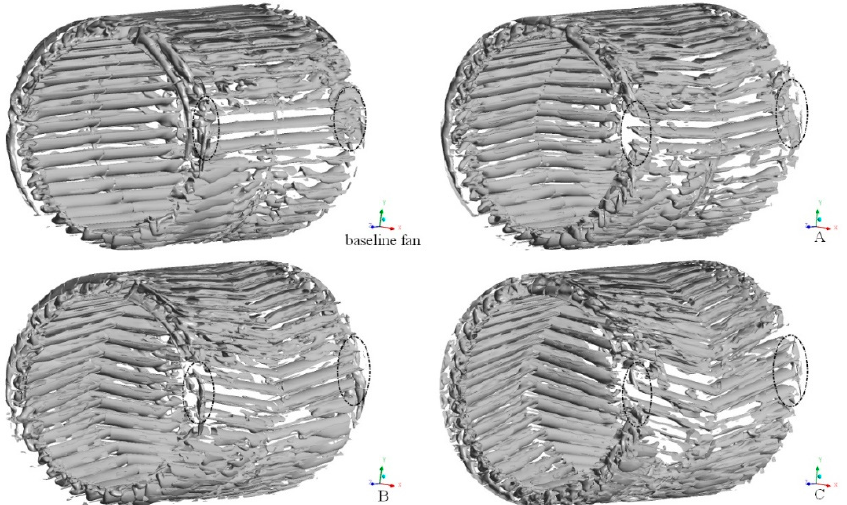
Figure 25. Three-dimensional distribution of vortices in impeller passages at Q / Q n = 1.760: ( A ) model-A; ( B ) model-B; ( C )